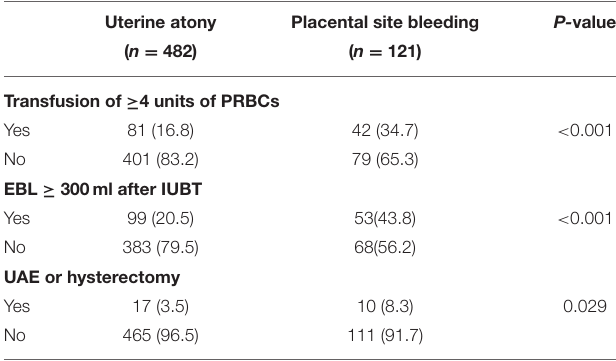
TABLE 1 | Demographic, obstetric, and IUBT-related data were grouped according to IUBT indications.